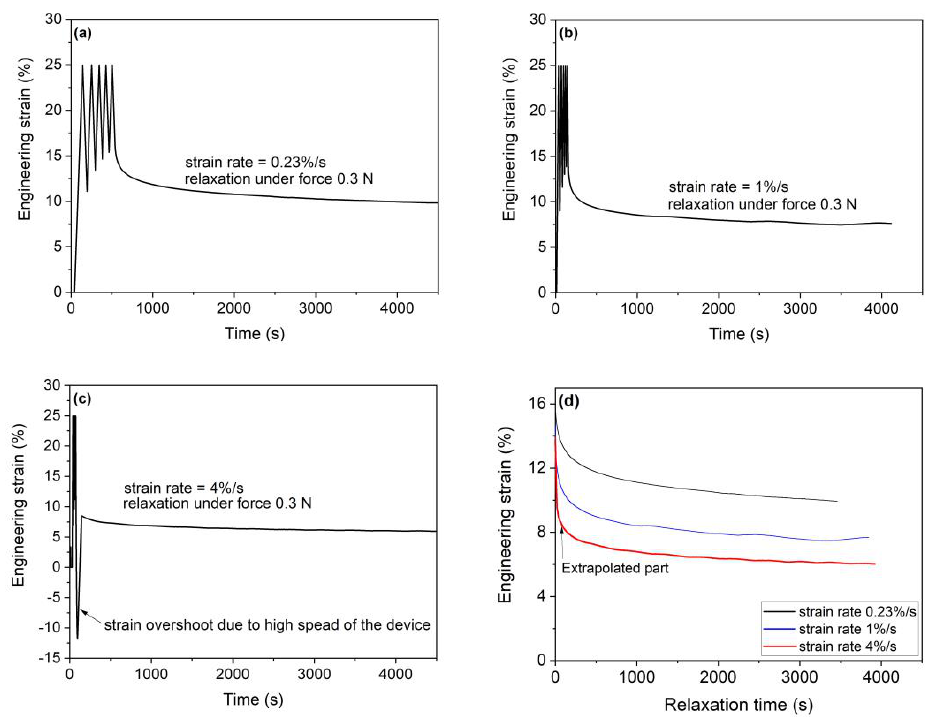
Figure 6. Dependence of strain recovery on time strain rate of ( a ) 0.23%/s, ( b ) 1%/s and ( c ) 4 %/s and ( d ) strain recovery versus relaxing time for all the test strain